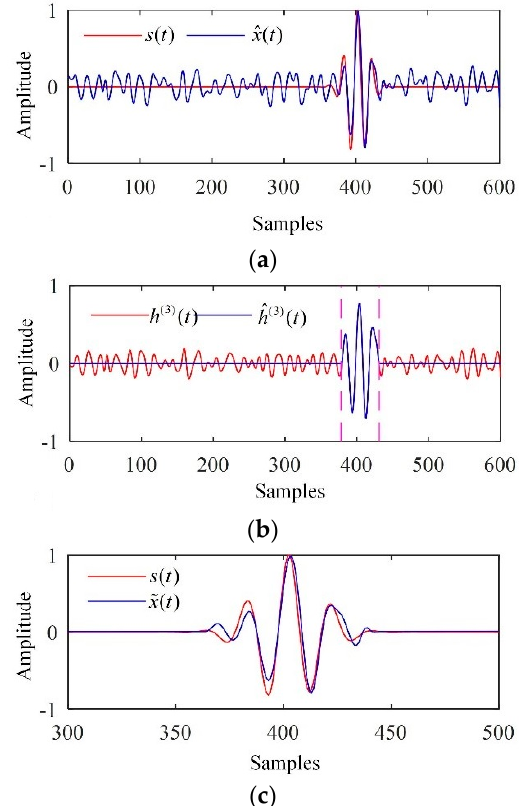
Figure 4. Processing results of the simulated signal. ( a ) The reconstructed signal given by partial reconstruction; ( b ) the detection interval in which the flaw echo was located; ( c ) the denoised signal.